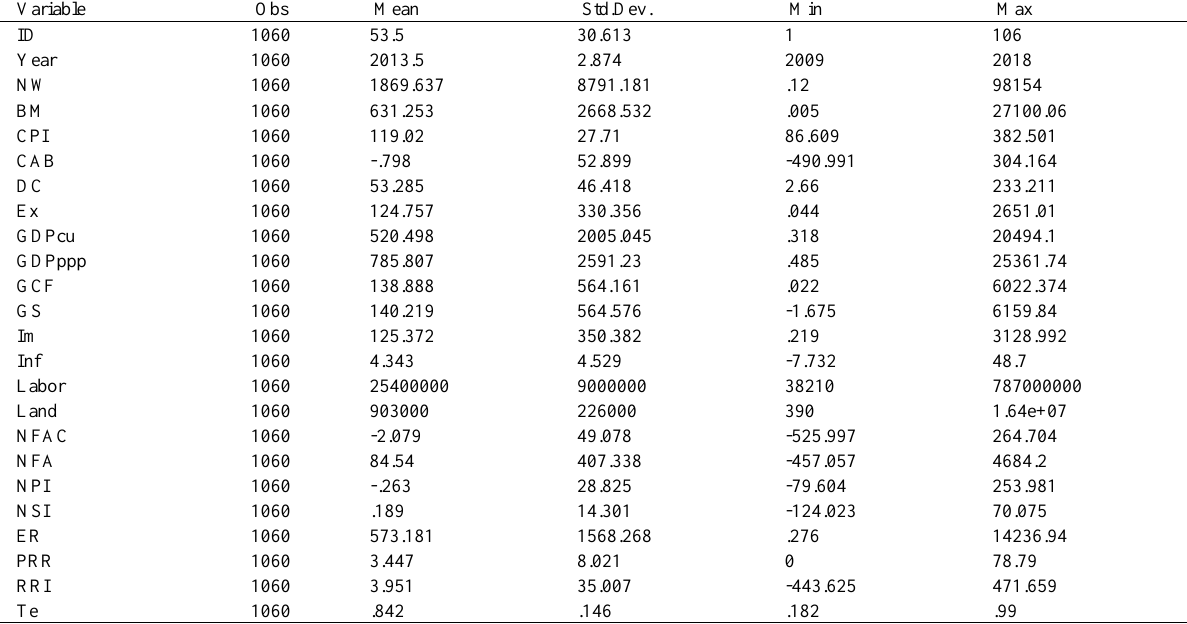
Table 4: Data summary